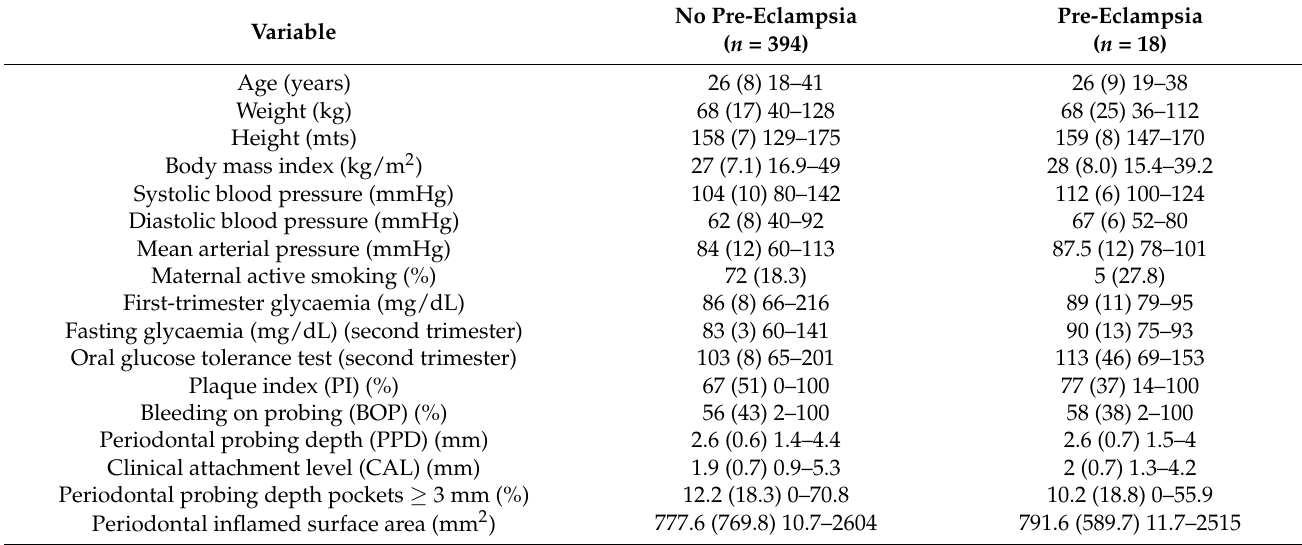
Table 1. Clinical, demographic, and periodontal descriptions of pregnant women at 11–14 weeks of